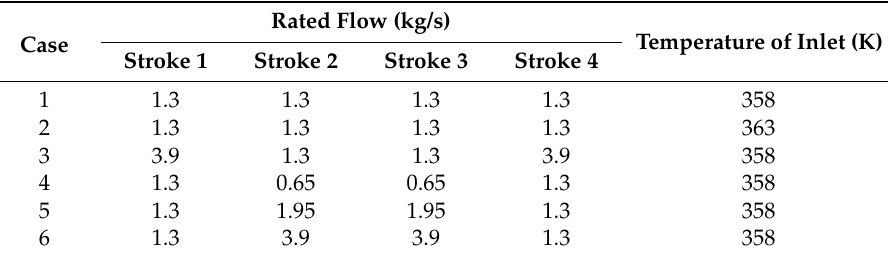
Table 3. Cooling operation conditions at 1200